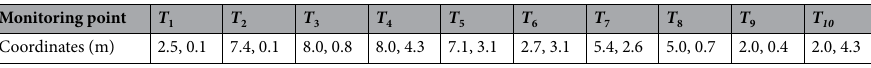
Table 1. Coordinates of each monitoring point.